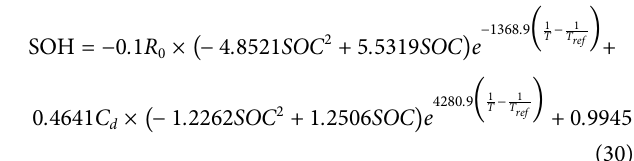
Frontiers in Energy Research |